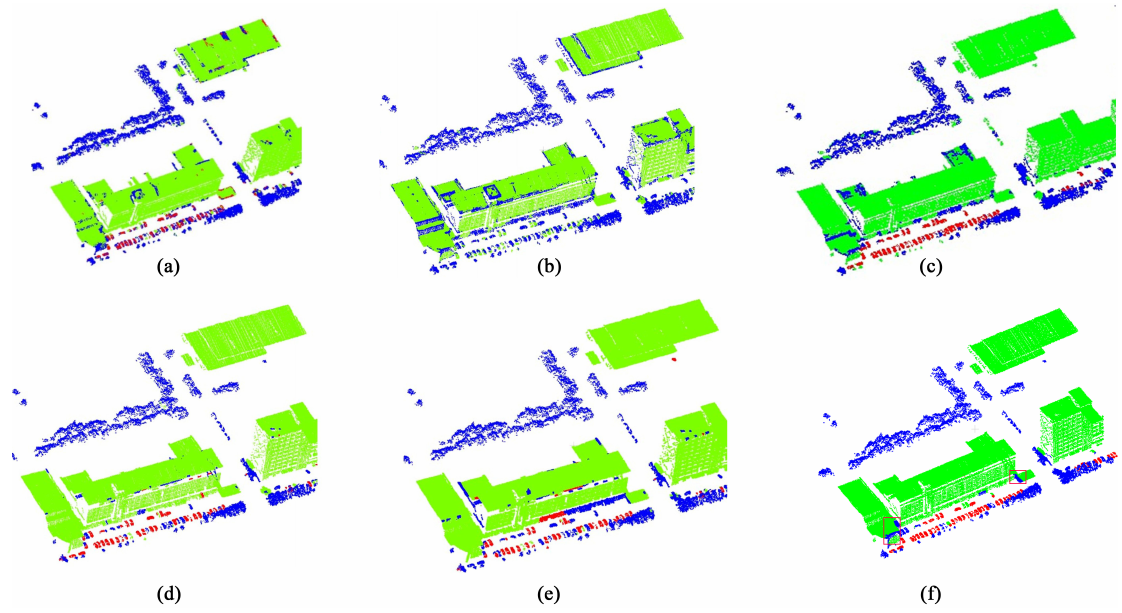
Figure 7. Comparison of the performance of six methods of classifying an urban scene. Subfigures ( a – e ) are the results generated by the state-of-the-art Methods 1 to 5. Our results are shown in ( f ). The color legend is defined in Figure